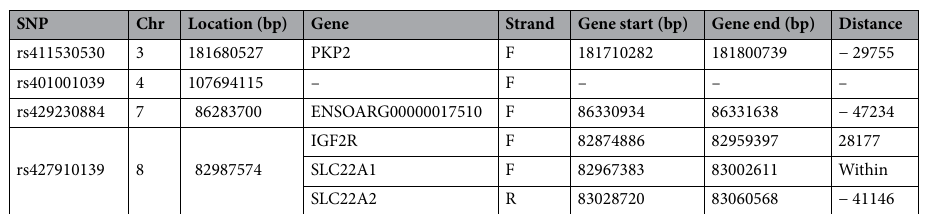
Table 2. The genes found in 50 kbp distances from the detected significant SNPs in GWAS, based on BioMart tool of Ensembl database (www. ensem bl. org). PKP2: Plakophilin 2; IGF2R: Insulin like growth factor 2 receptor; SLC22A1: Solute carrier family 22 member 1; SLC22A2: Solute carrier family 22 member 2; F and R: forward and reverse strands, respectively; Negative and positive distances indicate the SNPs before and after the genes, respectively.